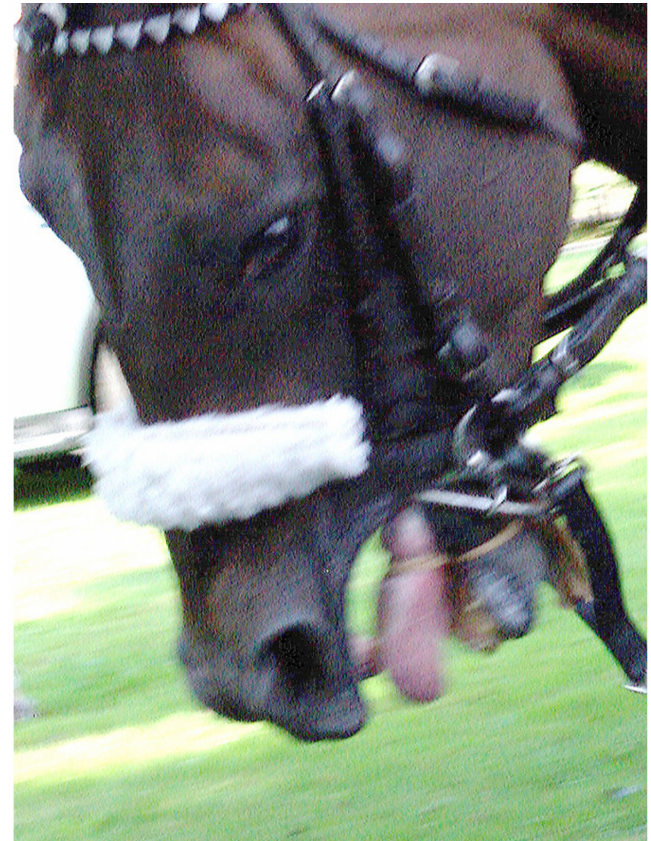
Figure 4. Image 4 for photo-elicitation